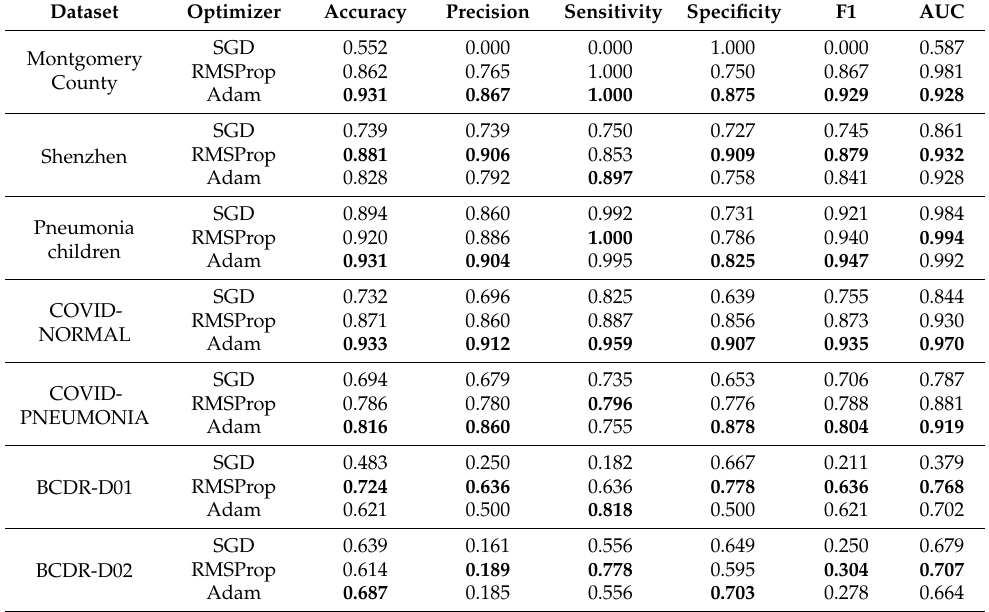
Table 5. Results using different optimizers for NanoChest-net.